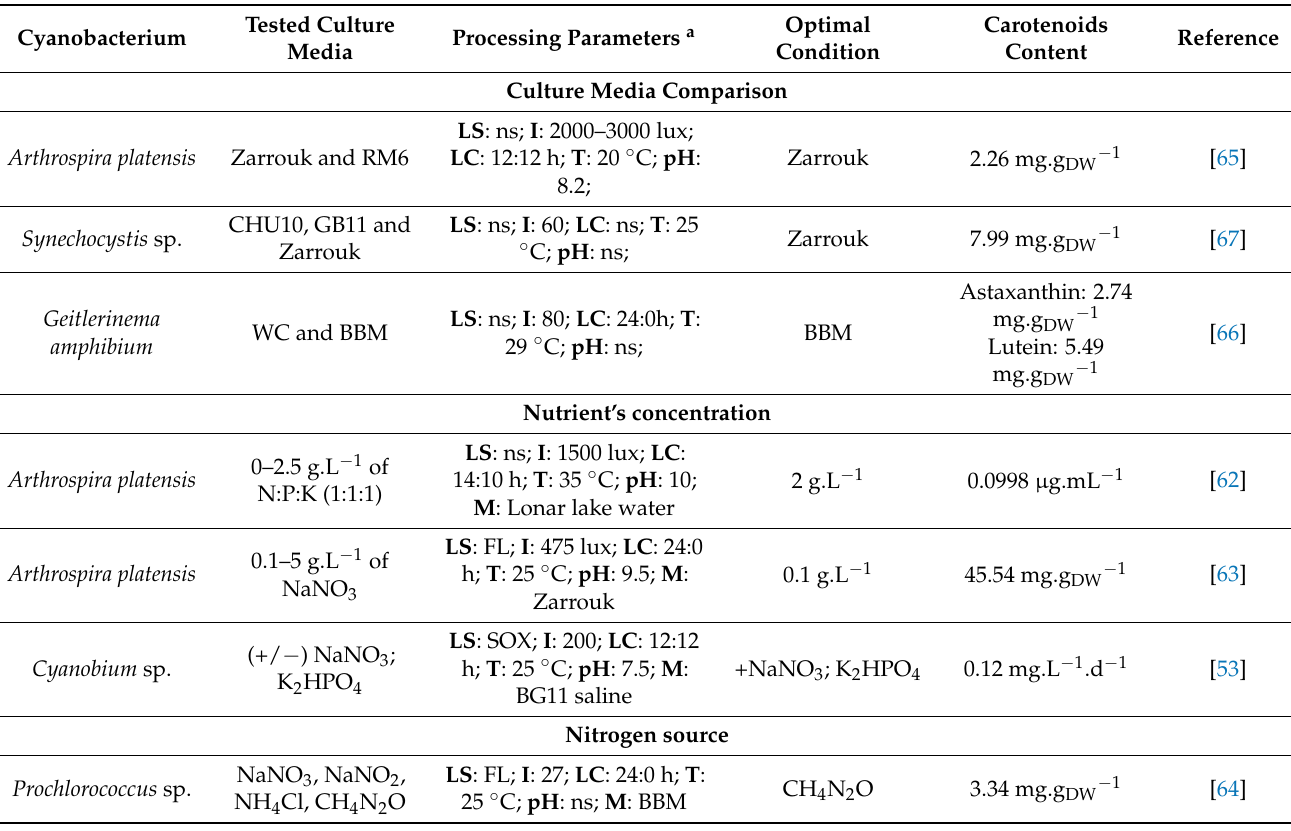
Table 4. Effects of culture medium composition on the production of carotenoids by cyanobacteria. Processing parameters include: light source (LS) and intensity (I), light:dark cycle (LC), temperature (T), pH, and culture media (M). Light intensity is expressed in µ mol photons .m − 2 .s − 1 unless another unit is